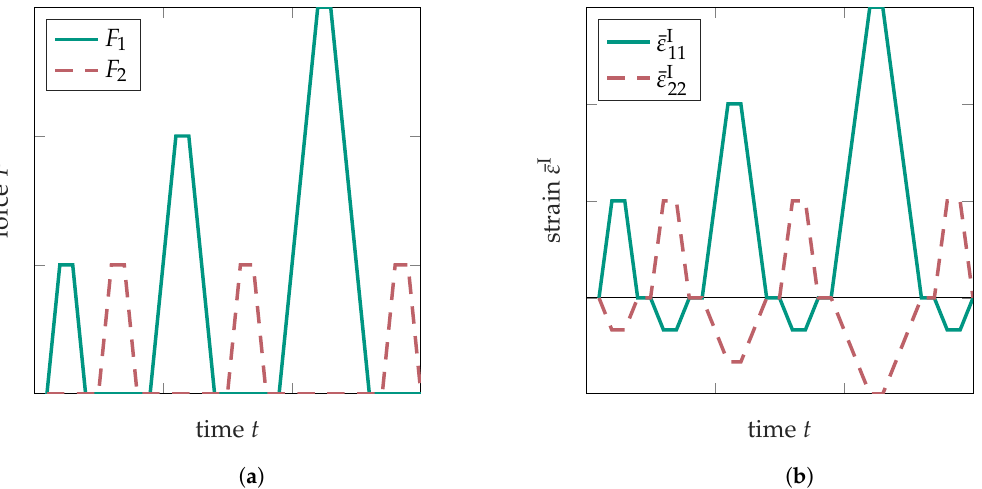
Figure 2. Schematic force and strain paths for experimental procedure P Γ = 0 . ( a ) Force path for procedure P Γ = 0 ; ( b ) Strain path for procedure P Γ = 0 .